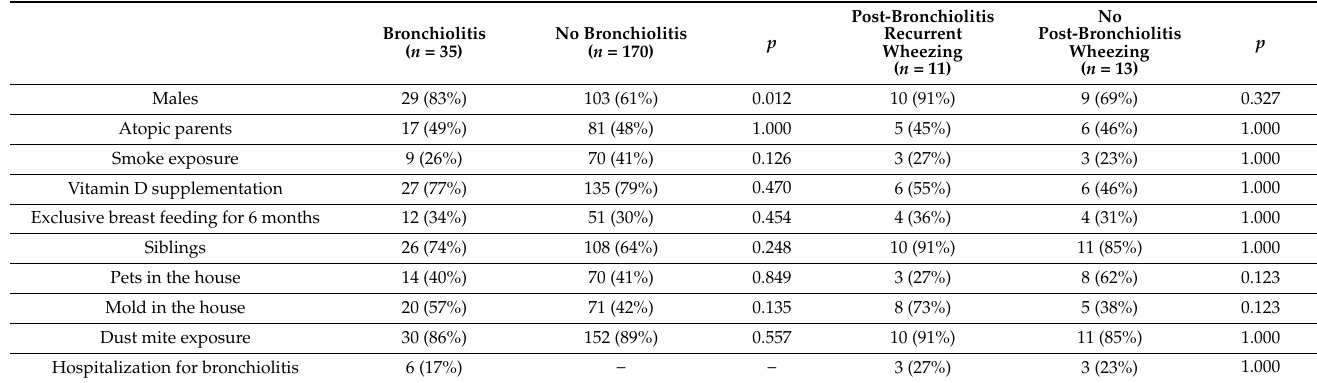
Table 1. Risk factors distribution in children according to the development of bronchiolitis and post bronchiolitis recurrent